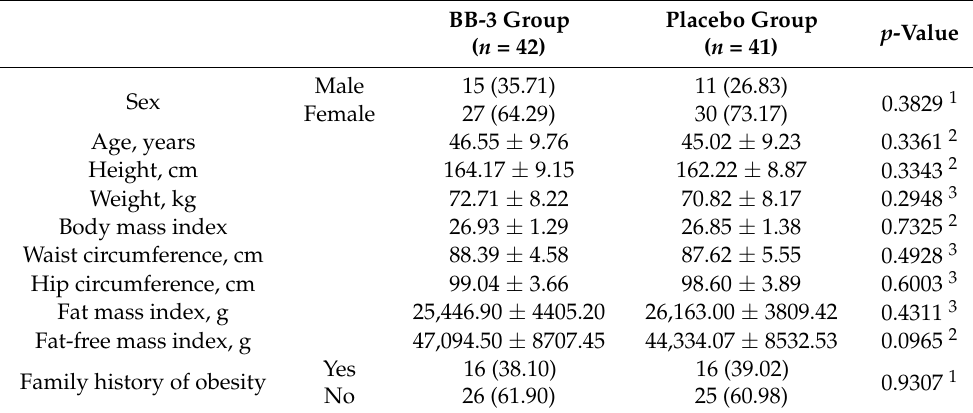
Figure 3. Trial flowchart. COVID-19: coronavirus disease 2019, PP: per protocol. Table 2. Participant characteristics by